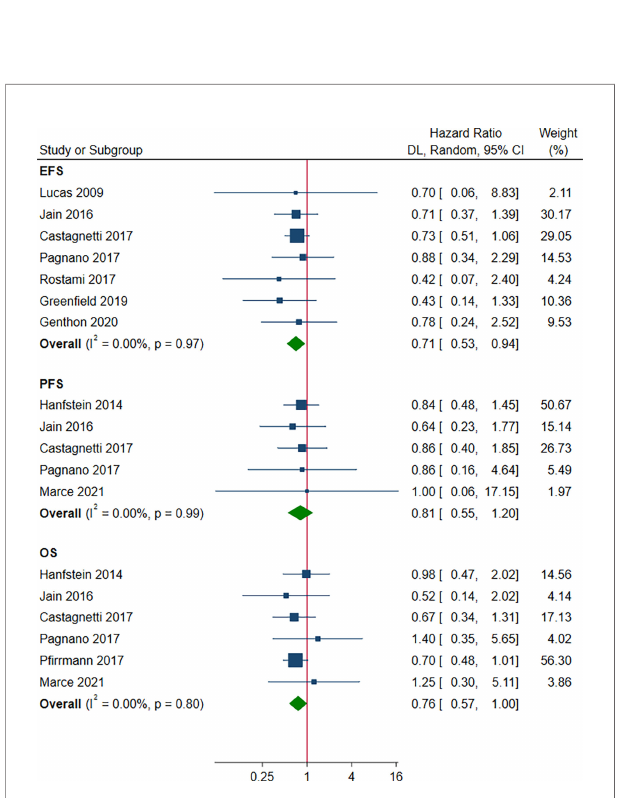
FIGURE 6 | Survival outcomes for patients with the e14a2 and e13a2